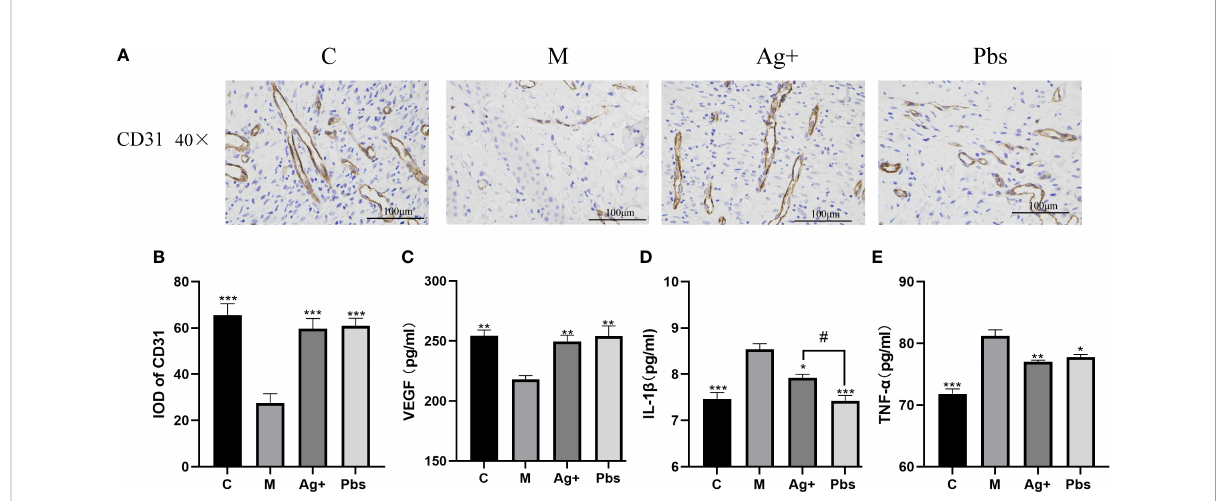
FIGURE 3 Effects of puffball spores on cytokine production in the serum of diabetics rats. (A) CD31 expression in wound tissues was detected by immunohistochemistry (scale bar = 100 µm; magni fi cation, 400×; n = 3). (B) Quantitative data of wound tissue CD31 expression using IPP. (Means ± SEM, n = 3, **P < 0.01, ***P < 0.001 vs. model group). (C) VEGF, (D) IL-1 b and (E) TNF- a were assayed by ELISA. (Means ± SEM, n = 6, *P < 0.05, **P < 0.01 vs. model group; #P < 0.05 vs. positive